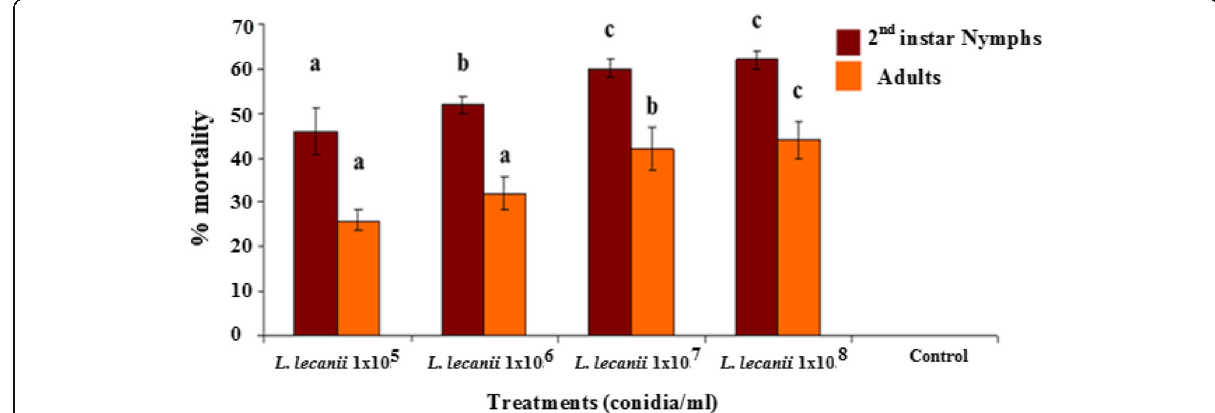
Fig. 3 Laboratory bio-efficacy of different concentrations of Lecanicillium lecanii against tea thrips Stethorus bispinosus (after 96 h). Values represent cumulative percent mortality, Means followed by the similar letter(s) in the columns are not significantly different at 5% by